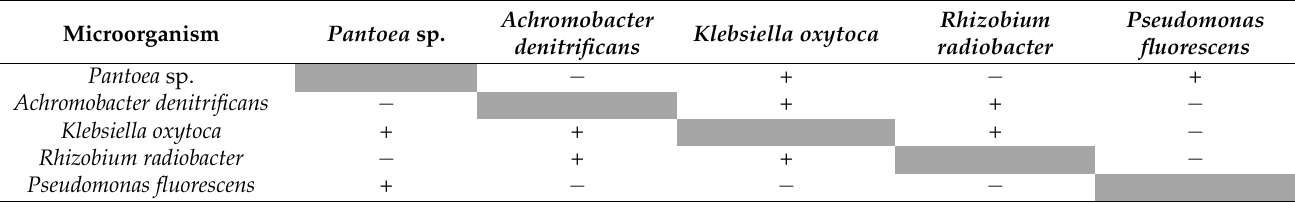
Table 5. Biocompatibility of the studied microorganisms.